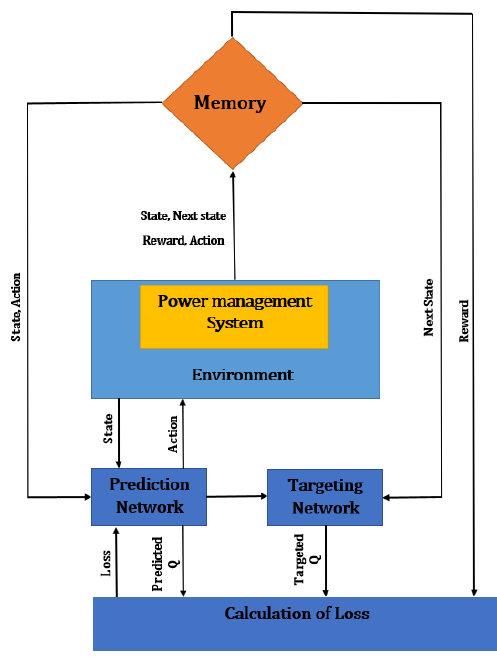
Figure 16. Deep Q-learning network .